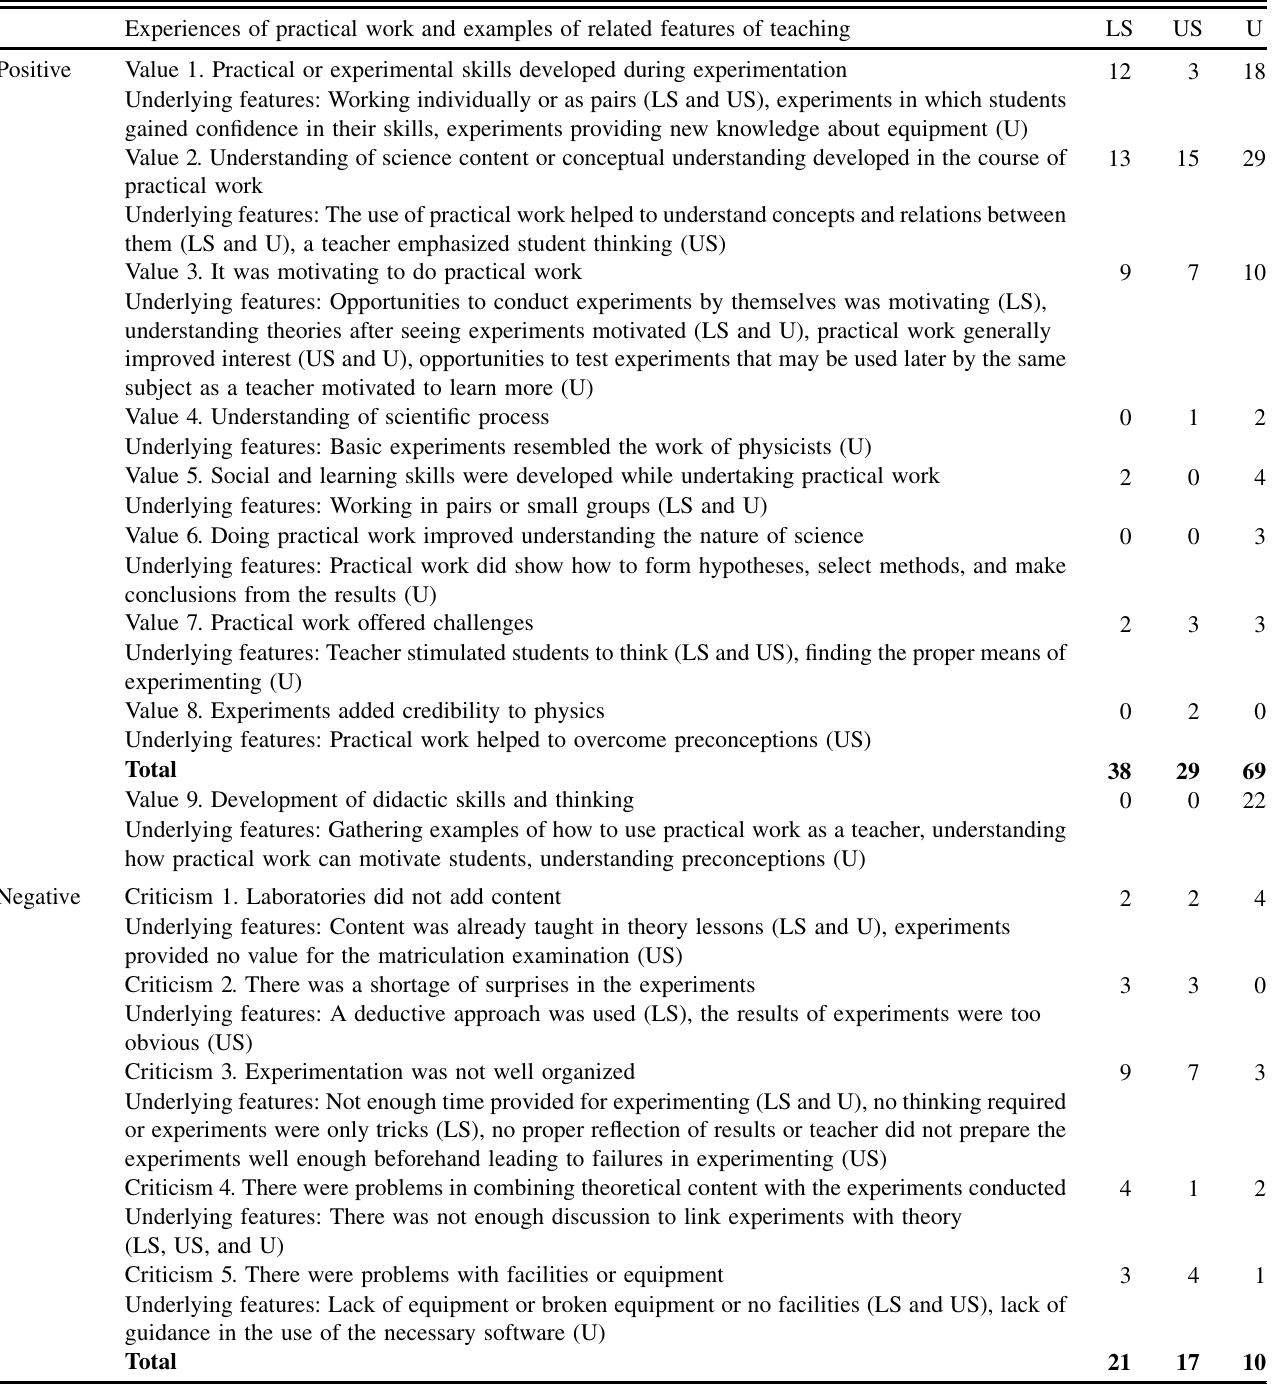
TABLE III. Preservice teachers’ ( n ¼ 32 ) descriptions of the values and criticism of practical work in their own experience and examples of the teaching features underlying such experiences. LS, lower secondary school; US, upper secondary school; U,